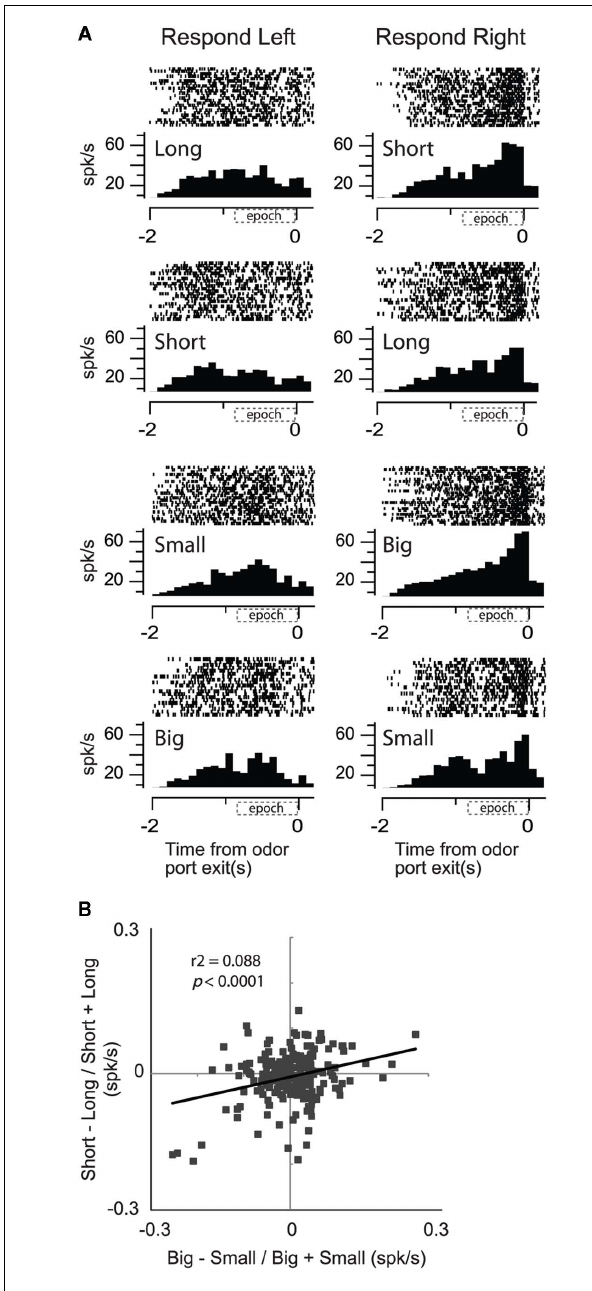
FIGURE 6 | Substantial nigra pars reticulata (SNr). Activity of single neurons in SNr reflects an interaction between expected value and direction. (A) Activity of a single SNr neuron averaged over all trials for each condition aligned on odor port exit during all eight conditions (four rewards × two directions). Histogram represents average activity over the last 10 trials (after learning) for each condition in a block of trials. Each tick mark is an action potential and trials are represented by rows. All trials are shown. (B) Correlation between size (big − small/big + small) and delay (short − long/short + long) effects averaged across direction (odor onset to odor port exit). Data was taken after learning (last 10 trials for each condition within each block; Bryden et al.,